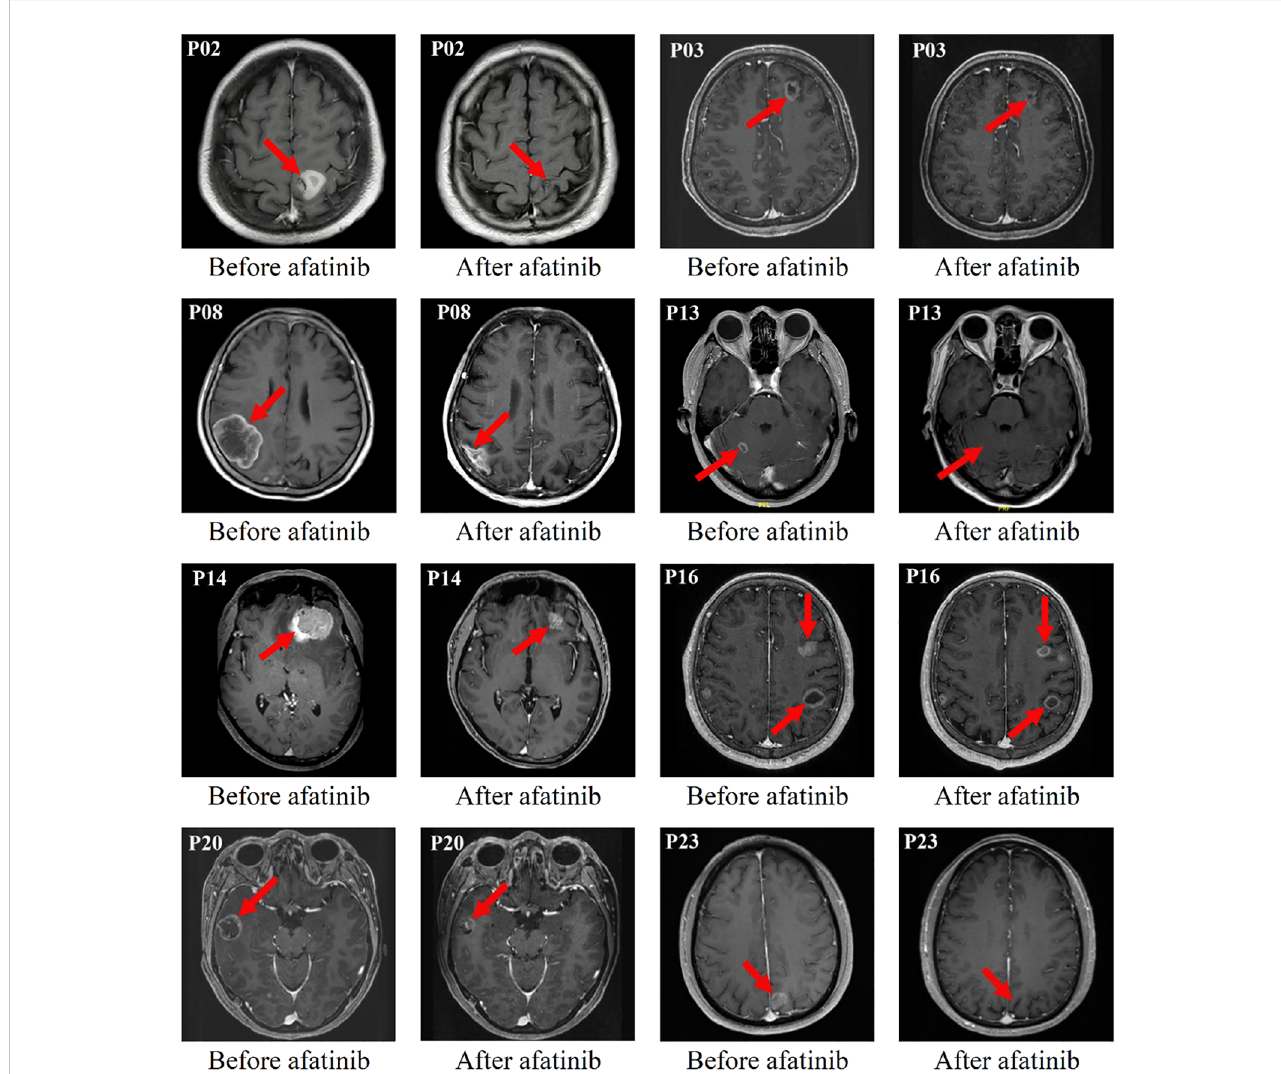
FIGURE 1 Eight typical examples of brain contrast MRI radiological changes in patients with measurable brain lesions (i.e. The red arrow